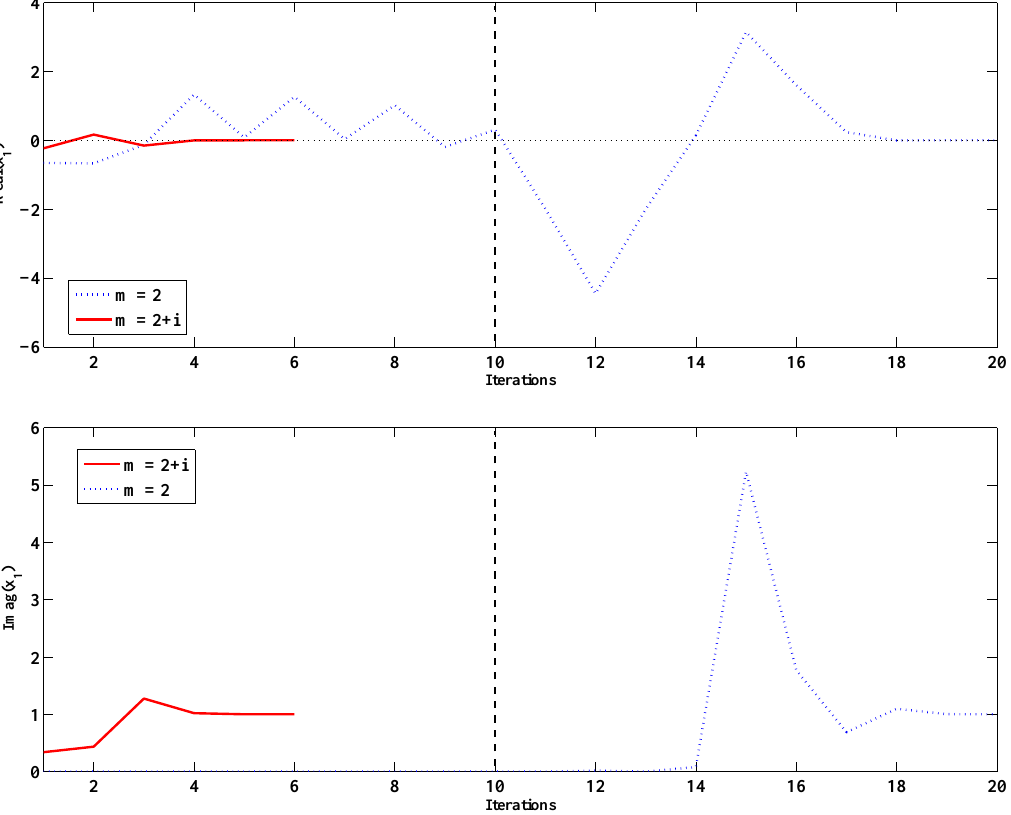
Figure 2. Evolution of real ( x 1 ) and imag ( x 1 ) as iterations progress for the simple system of Example 3 with m = 2 and m = 2 + i